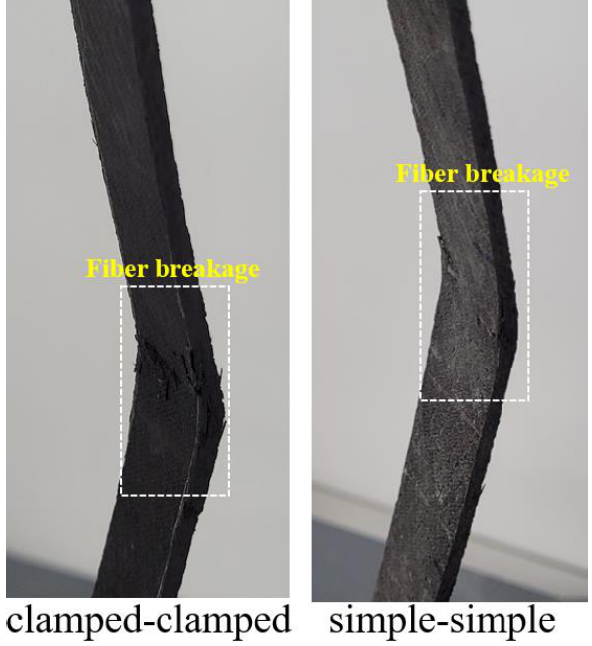
Figure 10. Damage analysis of simple – simple and clamped – clamped supported samples.